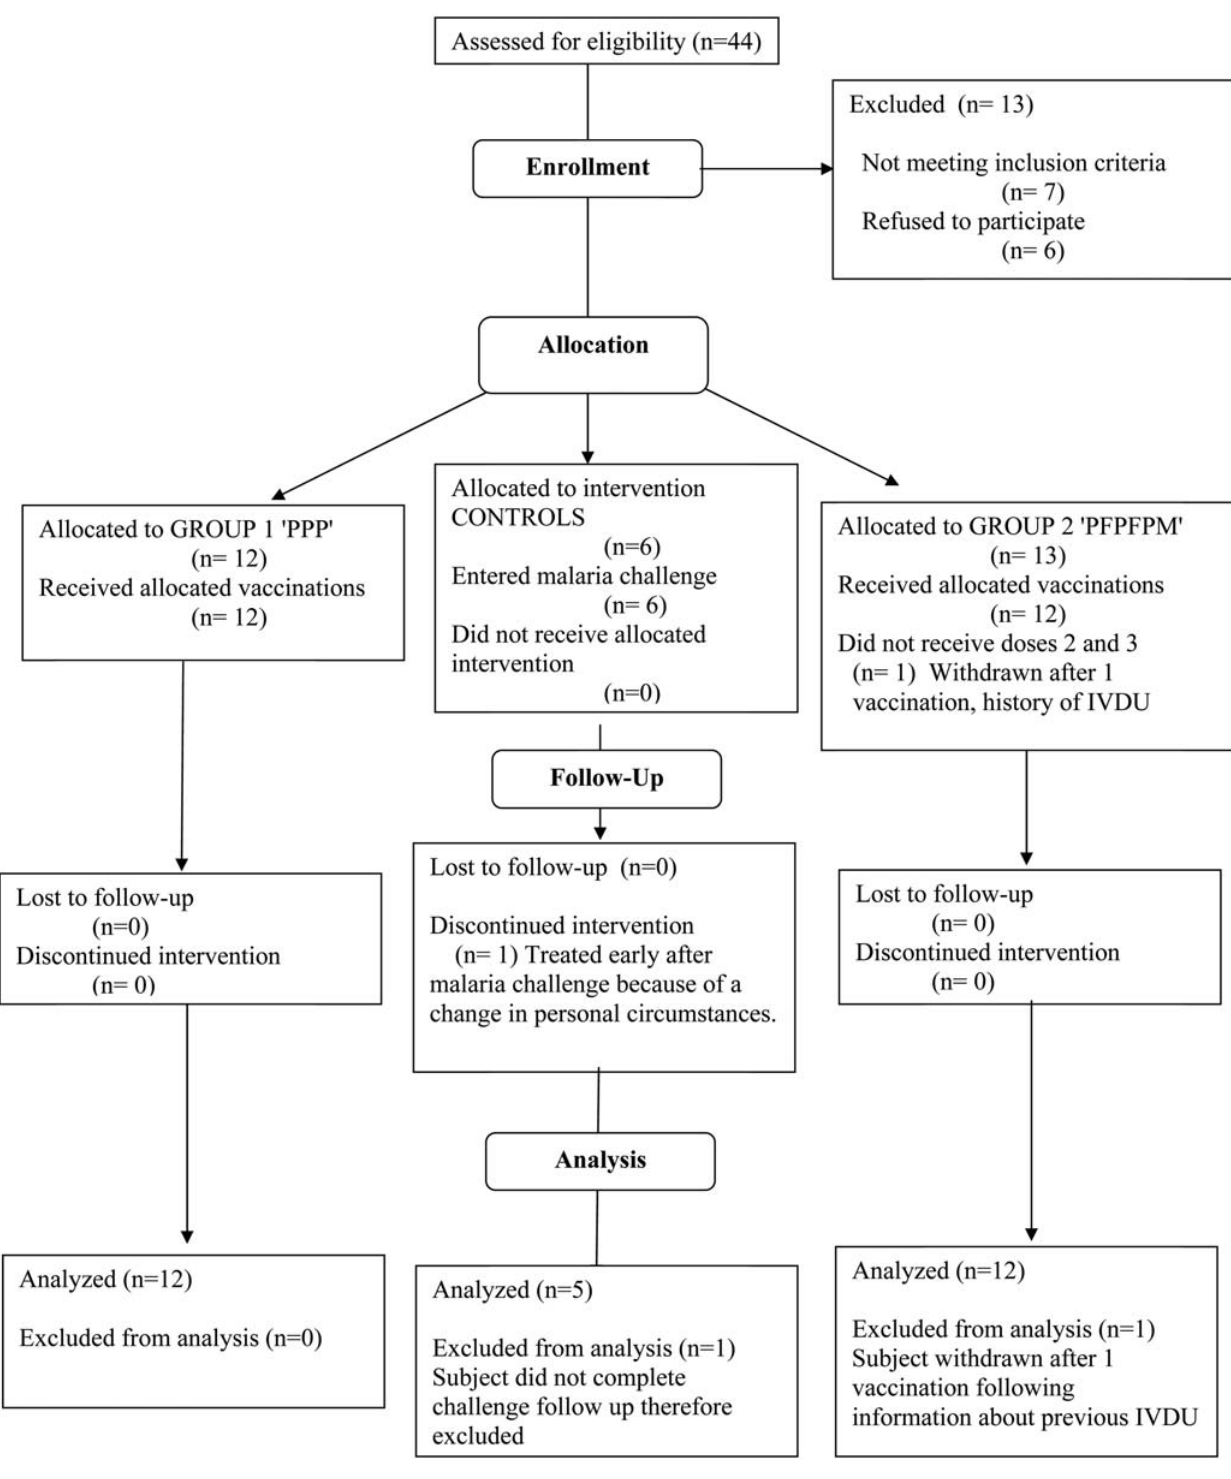
Figure 2. CONSORT Flow Chart